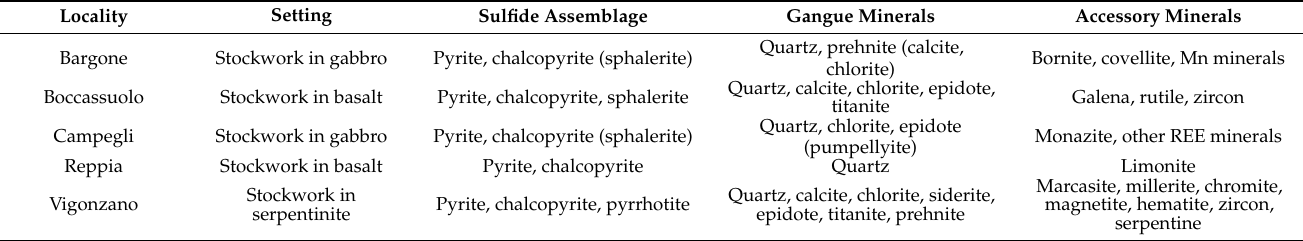
Table 1. Basic geological-mineralogical data of the studied localities (based on [32,37] and observations from this study).